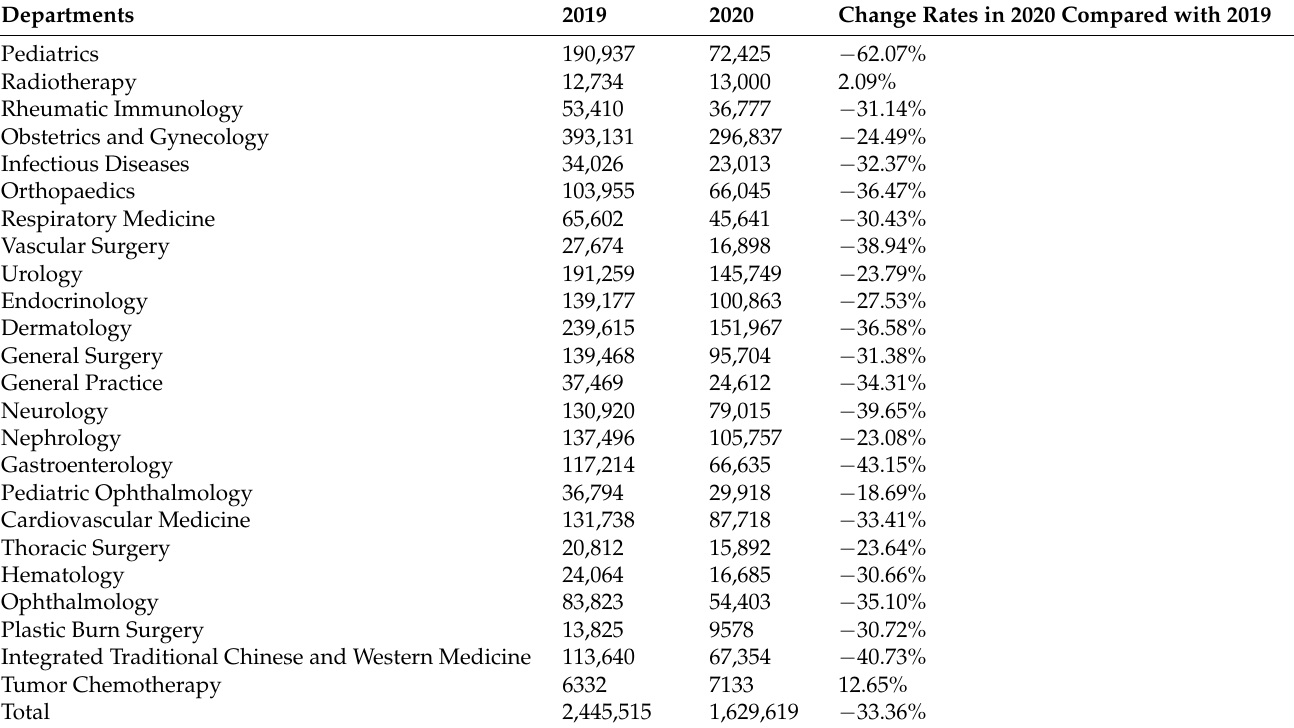
Table 1. Number of outpatients in each department in 2019 and